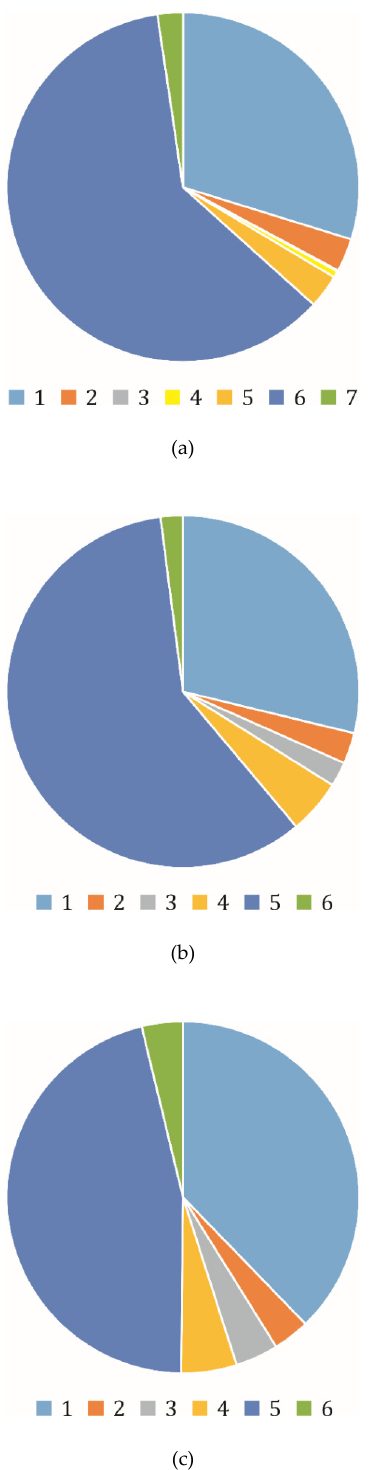
Figure 11. ( a ) Well-1(26) minerals and organic matter content (wt %), 1—quartz, 2—orthoclase + plagioclase, 3—calcite + dolomite, 4—gypsum, 5—Fe / Ti-minerals, 6—clay minerals, 7—organic